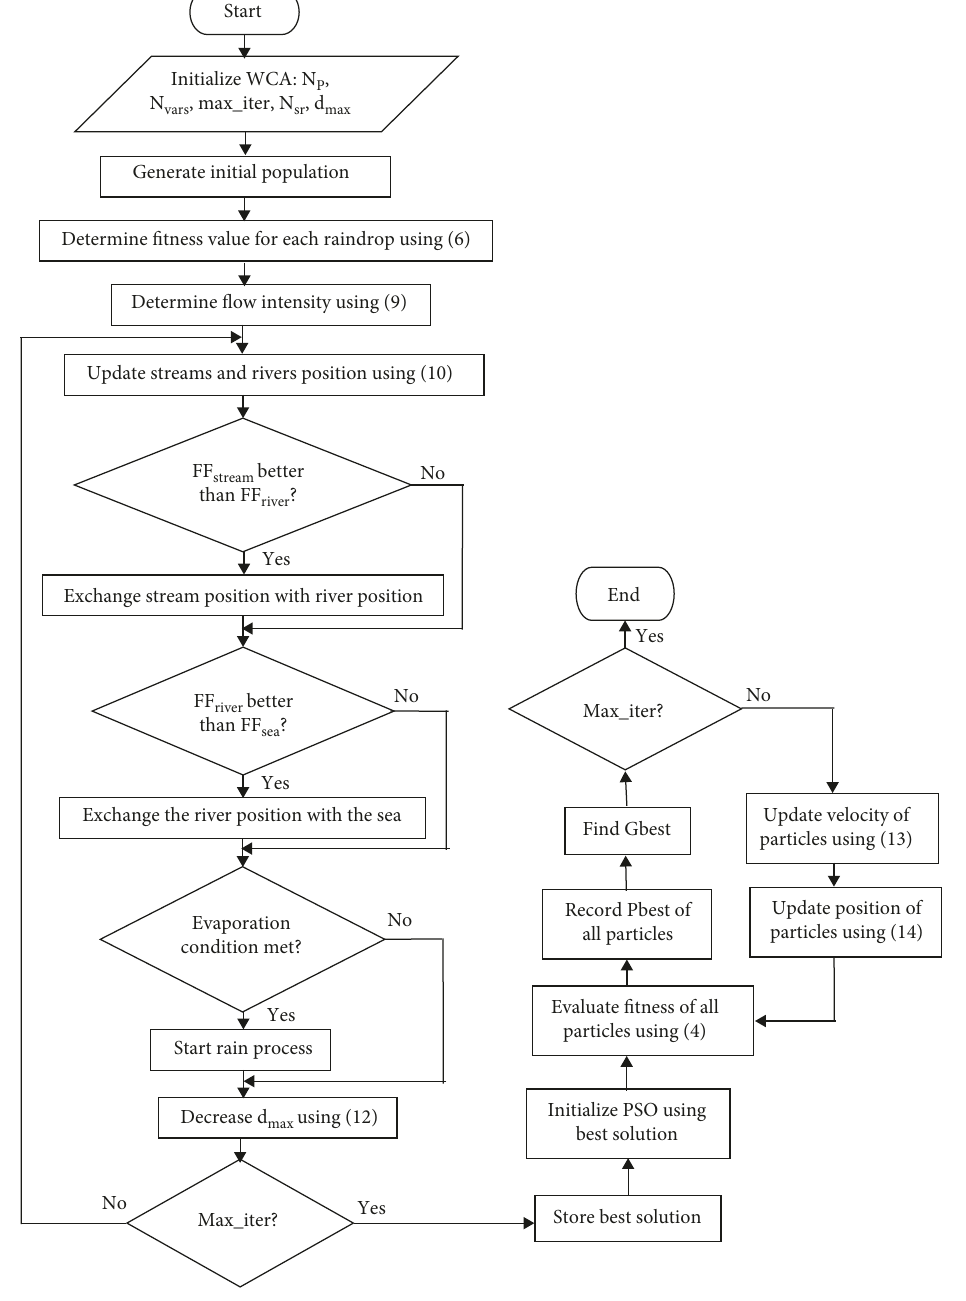
Figure 8: WCA-PSO flowchart [42,